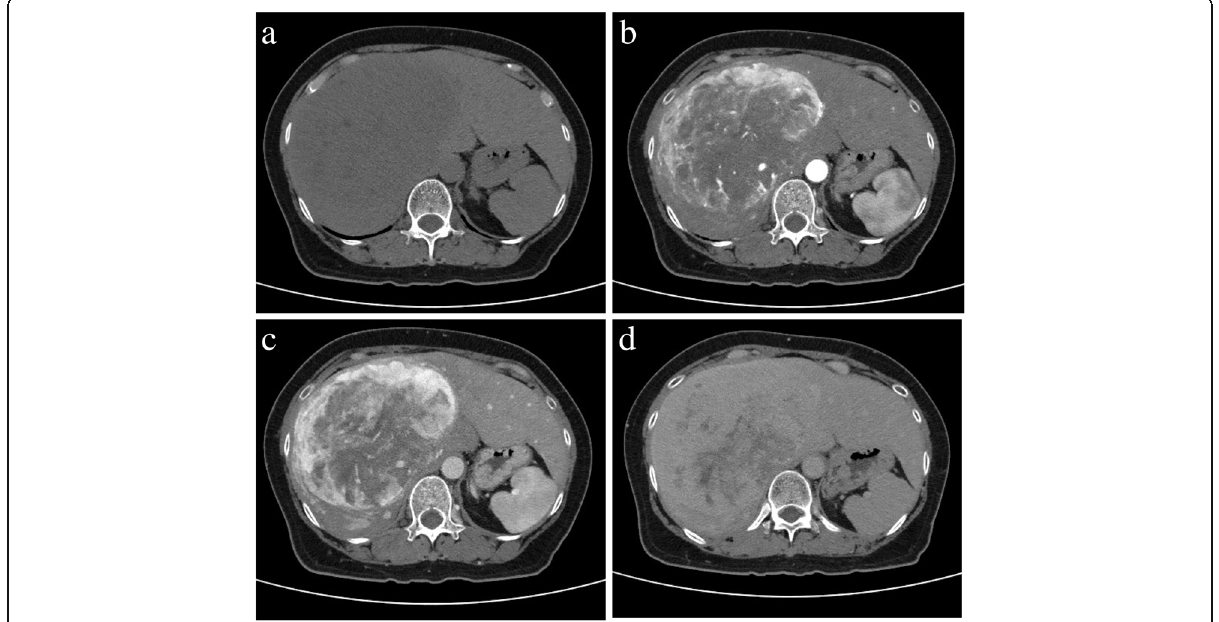
Fig. 1 Contrast-enhanced abdominal computed tomography (CT). Plain CT shows a well-defined low-density mass occupying the right lobe (14.0 cm diameter) ( a ). Contrast-enhanced CT shows heterogeneous enhancement in the peripheral mass during the arterial phase ( b ). Enhancement is then centripetal and more pronounced during the portal phase ( c ) and finally progresses to persistent, less heterogeneous enhancement during the delayed phase ( d